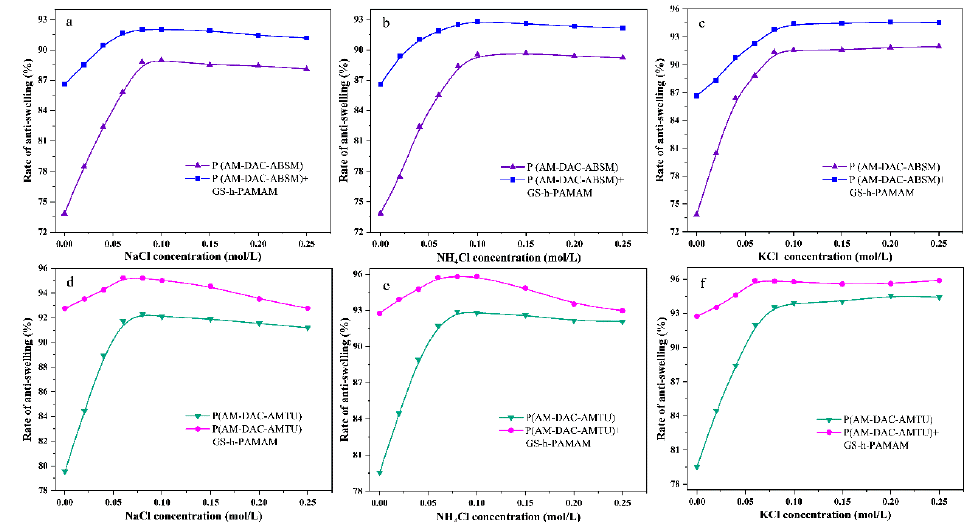
Figure 6. Effect of inorganic salts on rate of anti-swelling: (a-c) P(AM-DAC-ABSM) and its supramolecular system; (d-f) P(AM-DAC-AMTU) and its supramolecular system. supramolecular system; ( d – f ) P(AM-DAC-AMTU) and its supramolecular